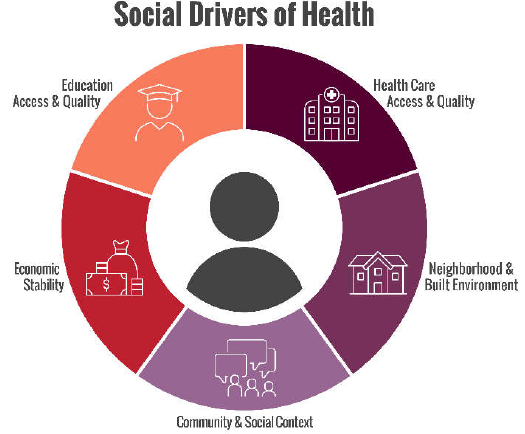
Figure 1. Social Drivers of Health framework adapted from Healthy People 2030.